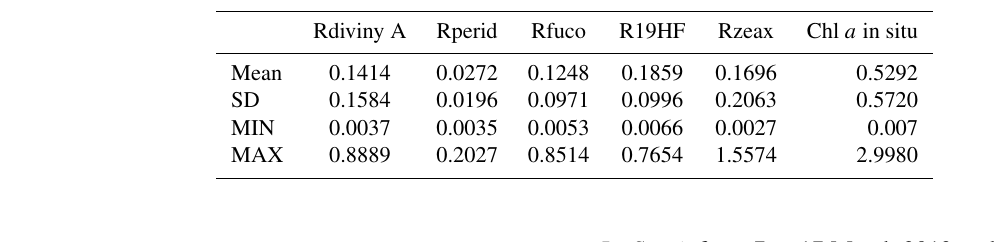
Figure 2. Geographic positions of the 515 in situ and satellite collocated measurements of the DPIG database. Table 1. Pigments of the DPIG and their statistical characteristics: SD (standard deviation), MIN (minimum value), MAX (maximum value).